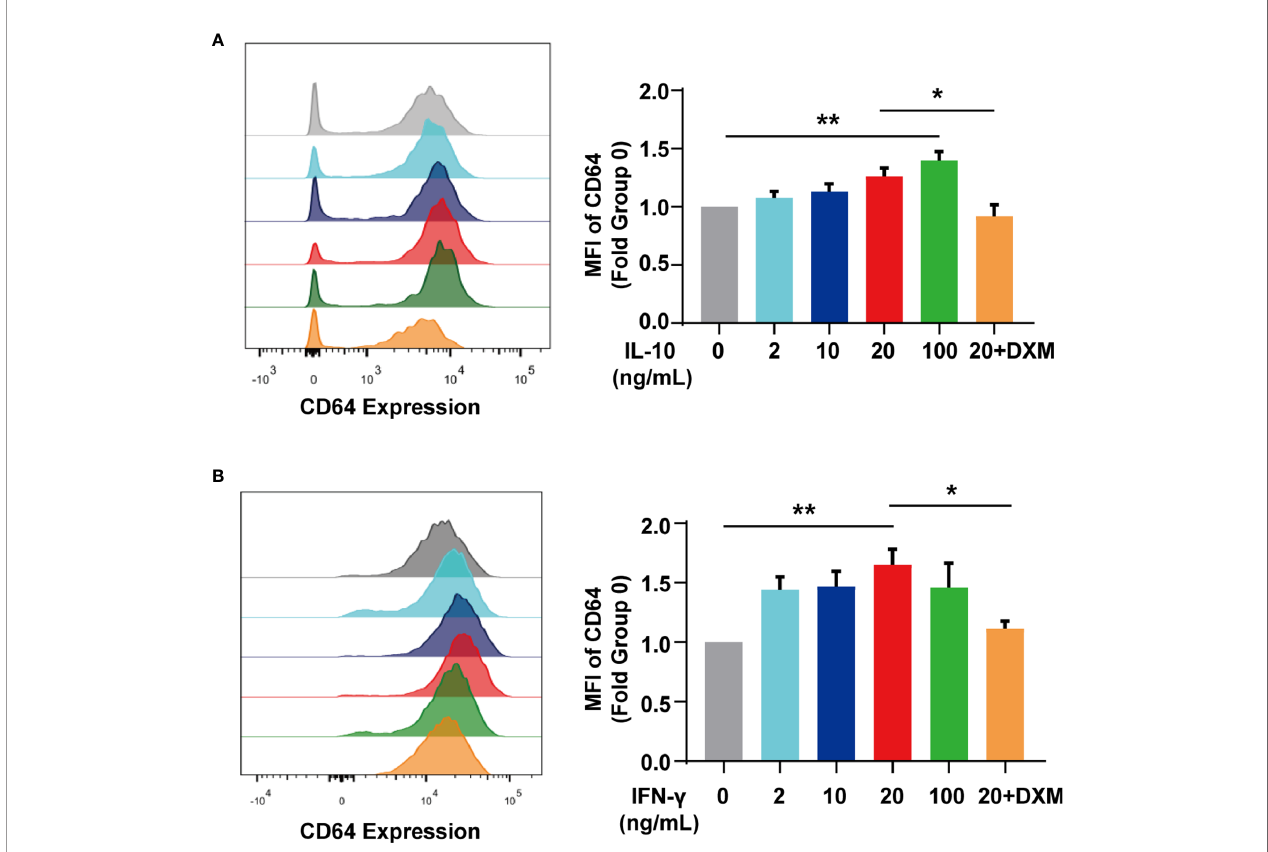
FIGURE 4 | IL-10 and IFN- g upregulated CD64 expression. (A) Flow cytometry detected CD64 expression in monocytes stimulated with various doses of IL-10 or 10 m M dexamethasone (DXM) for 20 h. Relative expression of CD64, showed as the fold group 0 ng/mL in MFI of monocytes. (B) Flow cytometry detected CD64 expression in monocytes stimulated with various doses of IFN- g or 10 m M dexamethasone (DXM) for 20 h. Relative expression of CD64, displayed as the fold group 0 ng/mL in MFI of monocytes. *p < 0.05, **p <